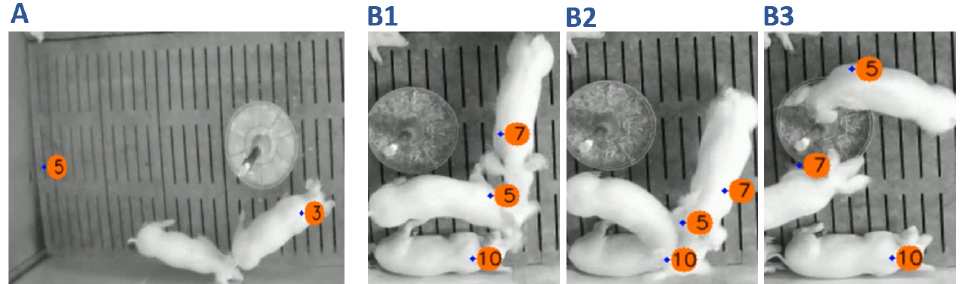
Figure 9. Examples of a failed tracking performance. ( A ) While the shoulder point of the lower pig was not tracked ( FN ), the corresponding ID was computed at an empty spot in the compartment ( FP ). ( B1 – B3 ) A case of an ID switch due to a close proximity interaction and the occlusion of an animal. Before the interaction takes place, ID 5 and ID 7 have been assigned correctly ( B1 ). After the interaction the IDs switched so that the ID 5 was assigned ID 7 and vice versa ( B3